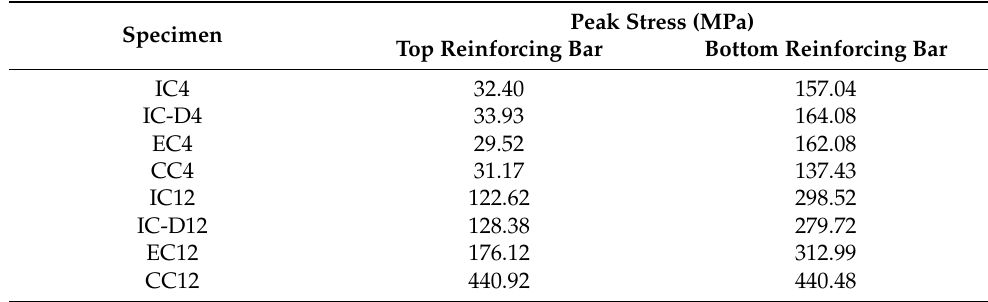
Table 5. Peak stresses in reinforcements of the